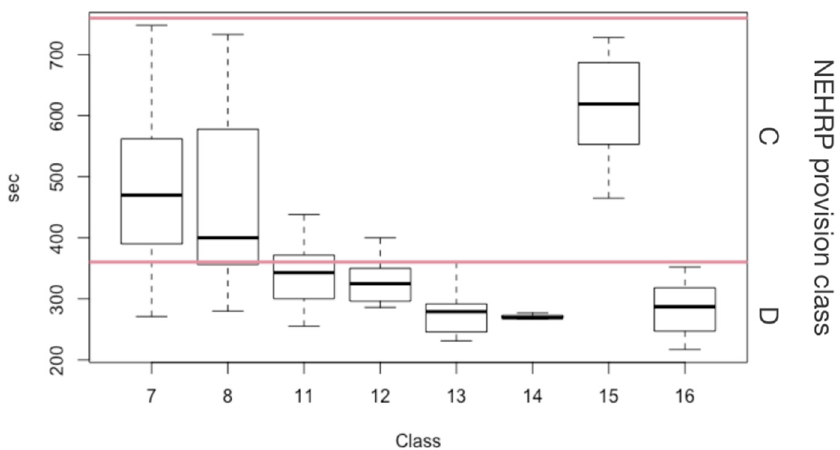
Figure 7. V S30 based on PBC geomorphological units; the red lines indicate the National Earthquake Hazards Reduction Program (NEHRP) classes.